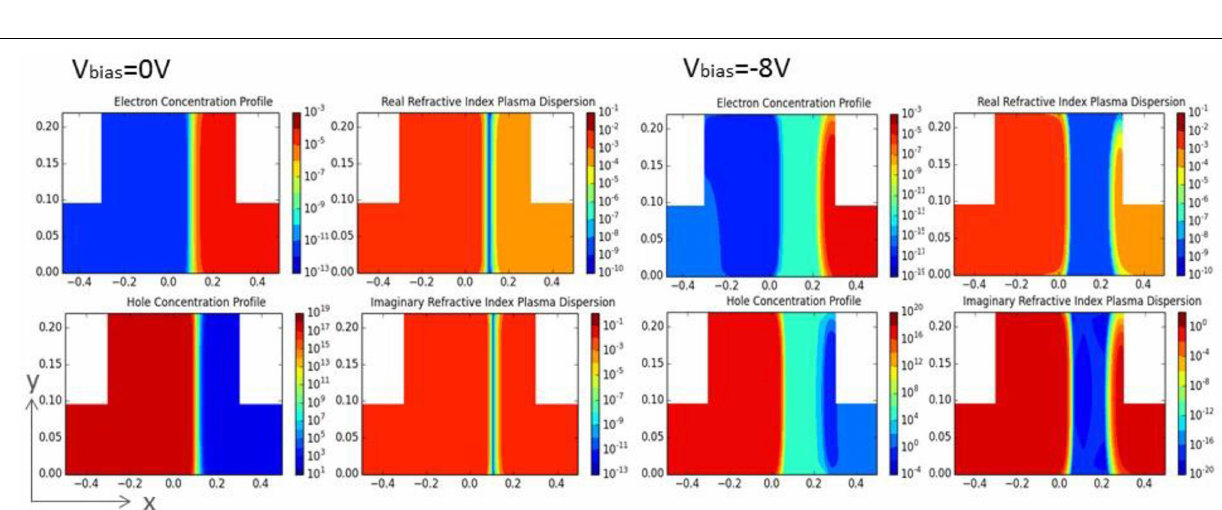
Frontiers in Physics |